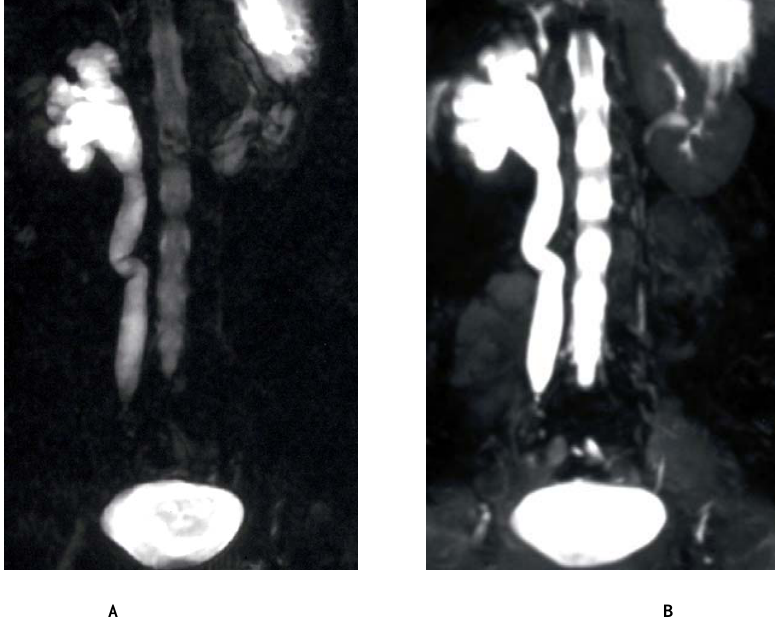
FIGURE 1. A case of stricture at right iliac ureter. (A) Single shot. (B) MIP reformatted multisection MRU shows the stricture and its level adequately at both